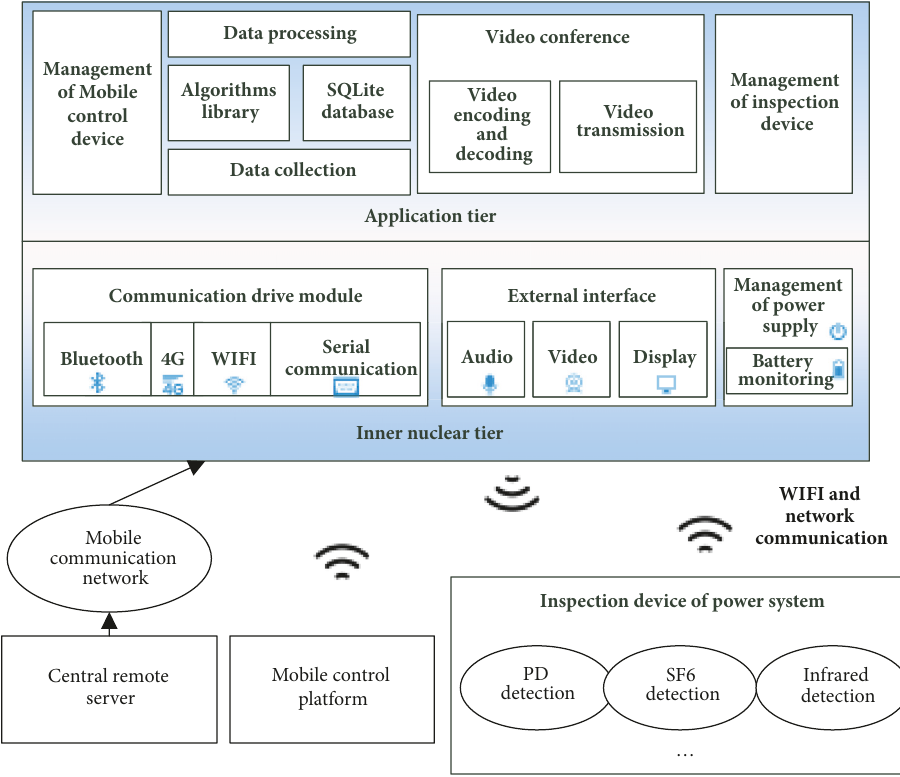
Figure 4: Software design of SOM box.